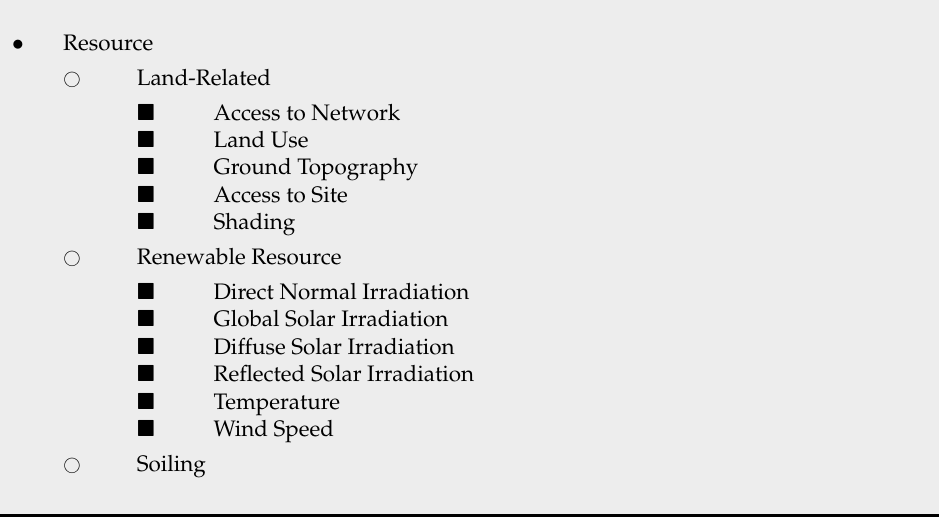
Table 8. Hierarchy for Resource-related topics in the Production of Electricity from CSP.